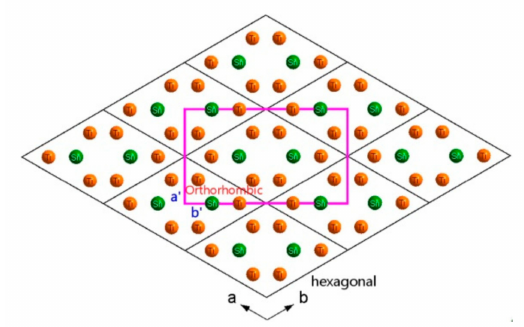
Figure 8. Comparison of the projection drawings of the hexagonal structure (drawn in black) and the orthorhombic structure (drawn in pink) of Ti 3 Sn from c axis, in which a, b axes of the hexagonal structure and a’, b’ axes of the orthorhombic structure were also